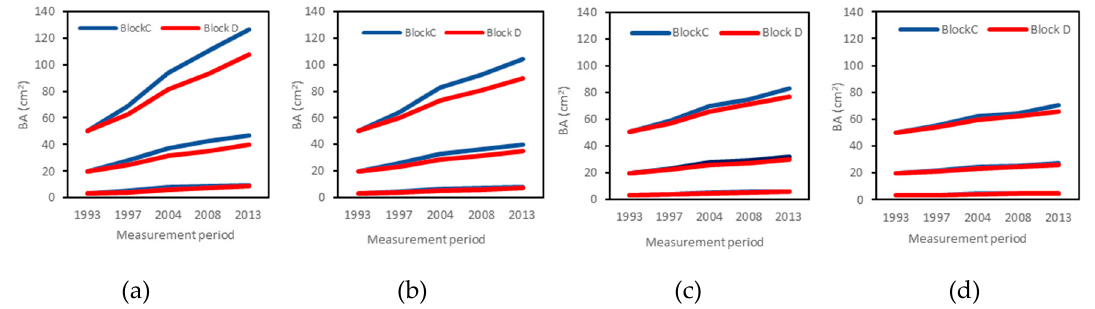
( d ) 90th percentile of competition.